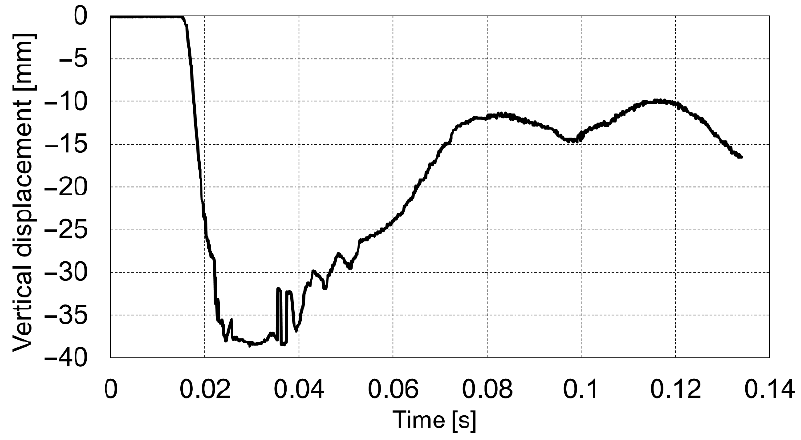
Figure 14. Displacements of the base plate during the third shot.